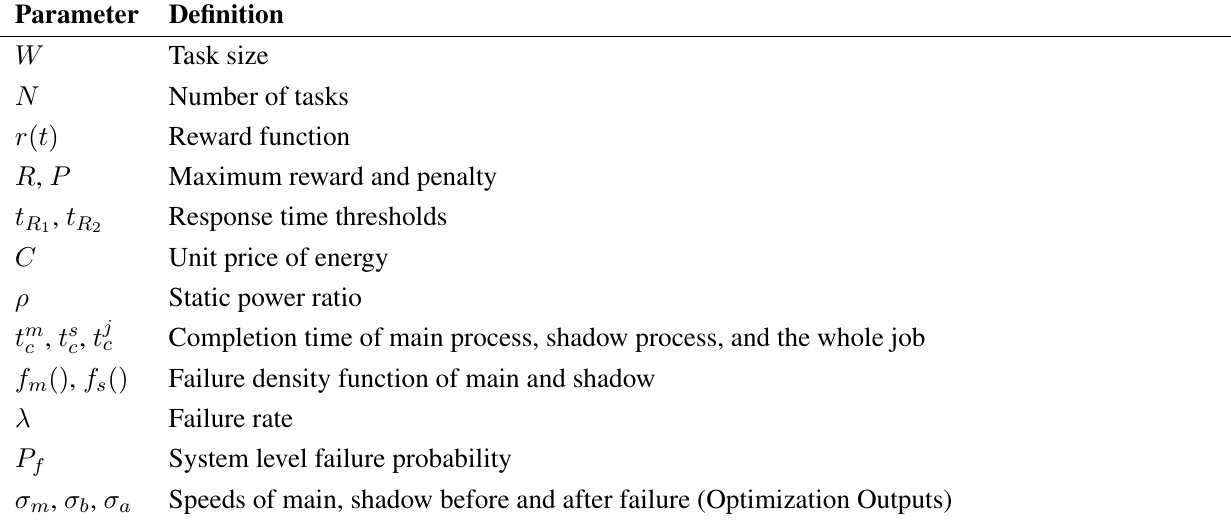
Table 2. Analytical model main